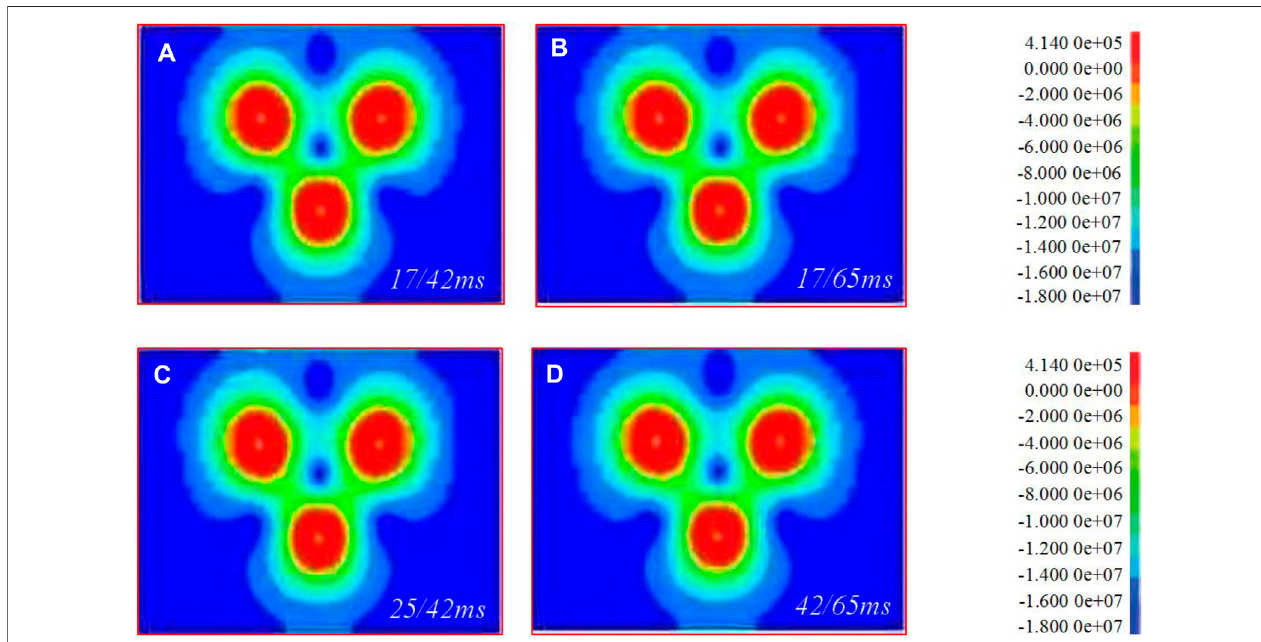
FIGURE 6 | 6 × 4 model 200 ms equivalent stress superposition. (A – D) are the superposition of equivalent stresses of 17/42 ms, 17/65 ms, 25/42 ms and 42/ 65 ms, respectively.